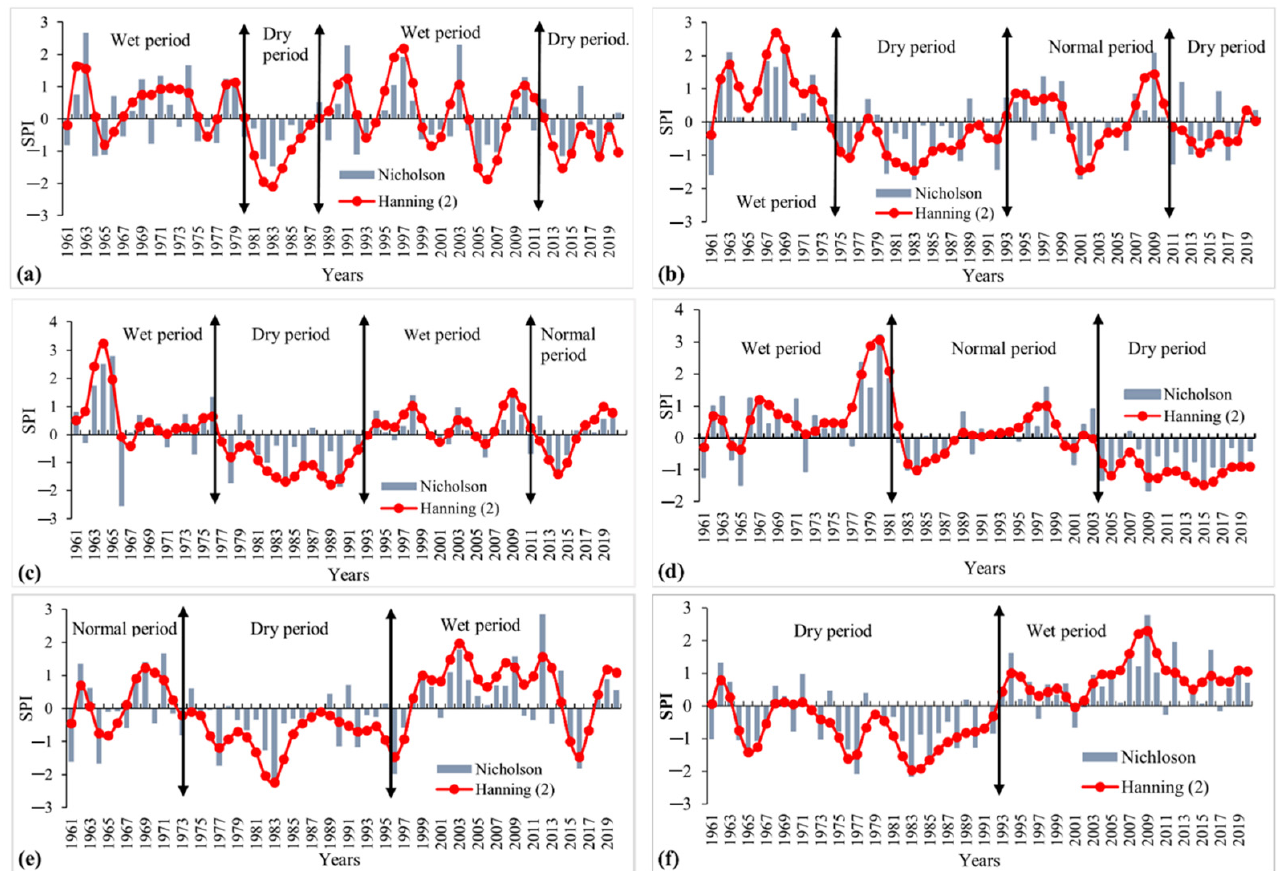
Figure 5. Nicholson’s index and Hanning’s low-pass filter of 2 applied to the KRW stations: ( a ) Kara; ( b ) Niamtougou; ( c ) Pagouda; ( d ) Alédjo-Kpéwa; ( e ) Guérin-Kouka and ( f ) Takpamba .